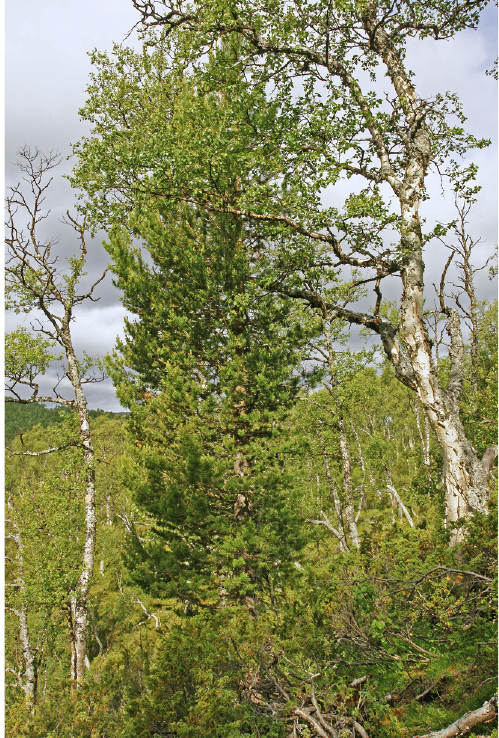
Figure 33. Young and vigorously growing pine tree, repre- senting 8 km upvalley and 65 m upslope spread since the ear- ly 20th century. Mt. Laptentjakke, 770 m a.s.l. 7 July